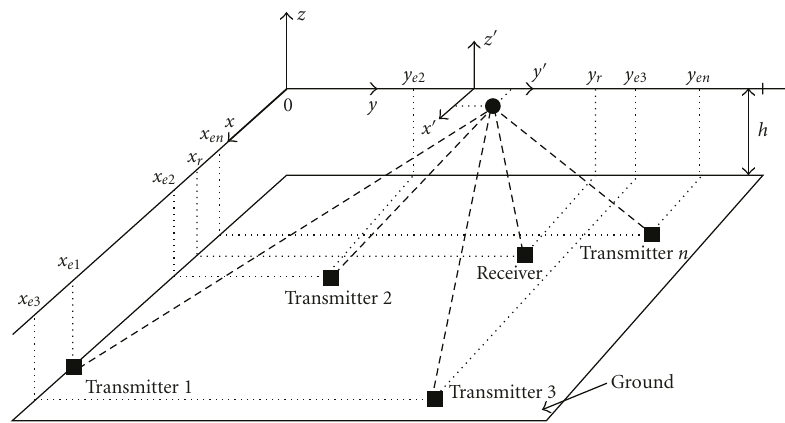
Figure 1: General scheme of a multifrequency and multistatic